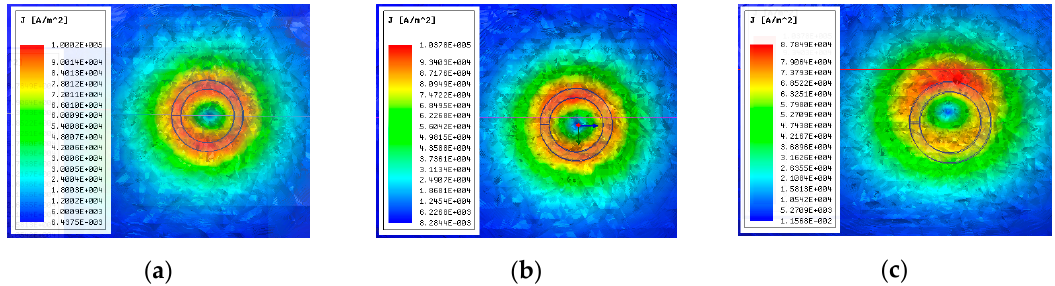
Figure 6. The eddy current distributions under different eccentricities: ( a ) E = 0 mm; ( b ) E = 1 mm; ( c ) E = 5 mm.